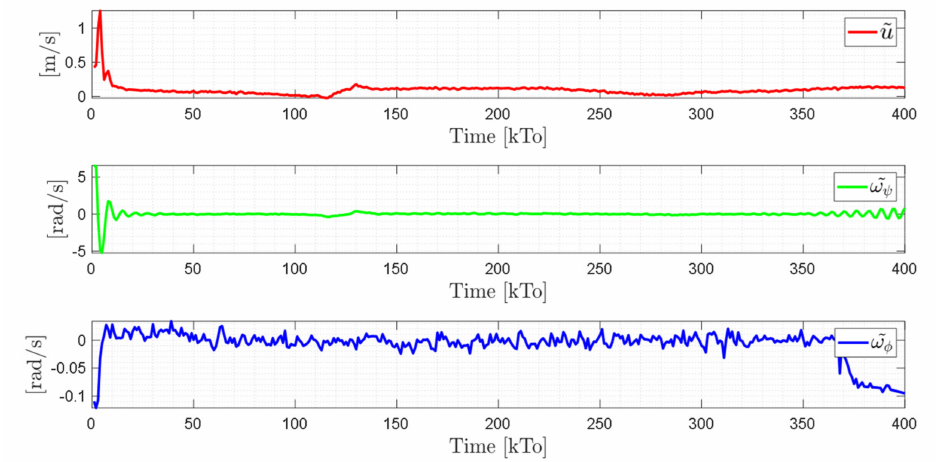
Figure 26. Time evolution of the control errors ˜ µ ( kT 0 ) = ( ˜ µ , ˜ ω ψ , ˜ ω φ